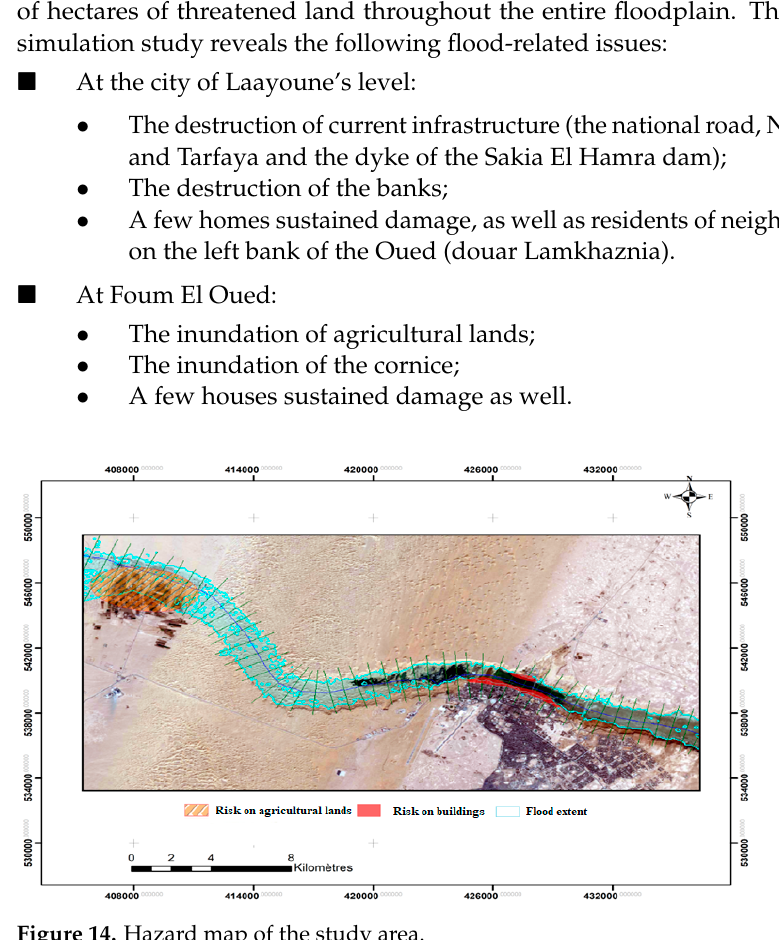
Figure 13. A representation of the floodplain for (Q100, Q50, Q20).